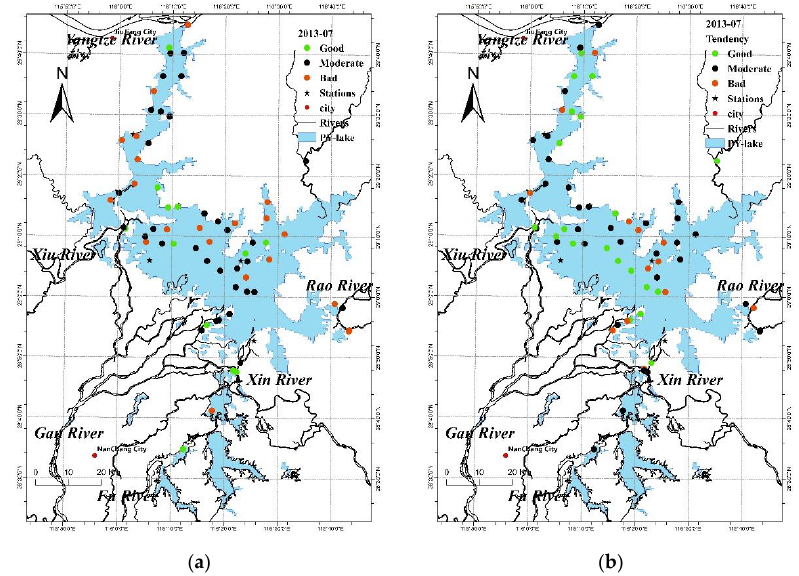
Figure 7. Health status ( a ) and tendency ( b ) of the aquatic ecosystem of Poyang Lake in July 2013.